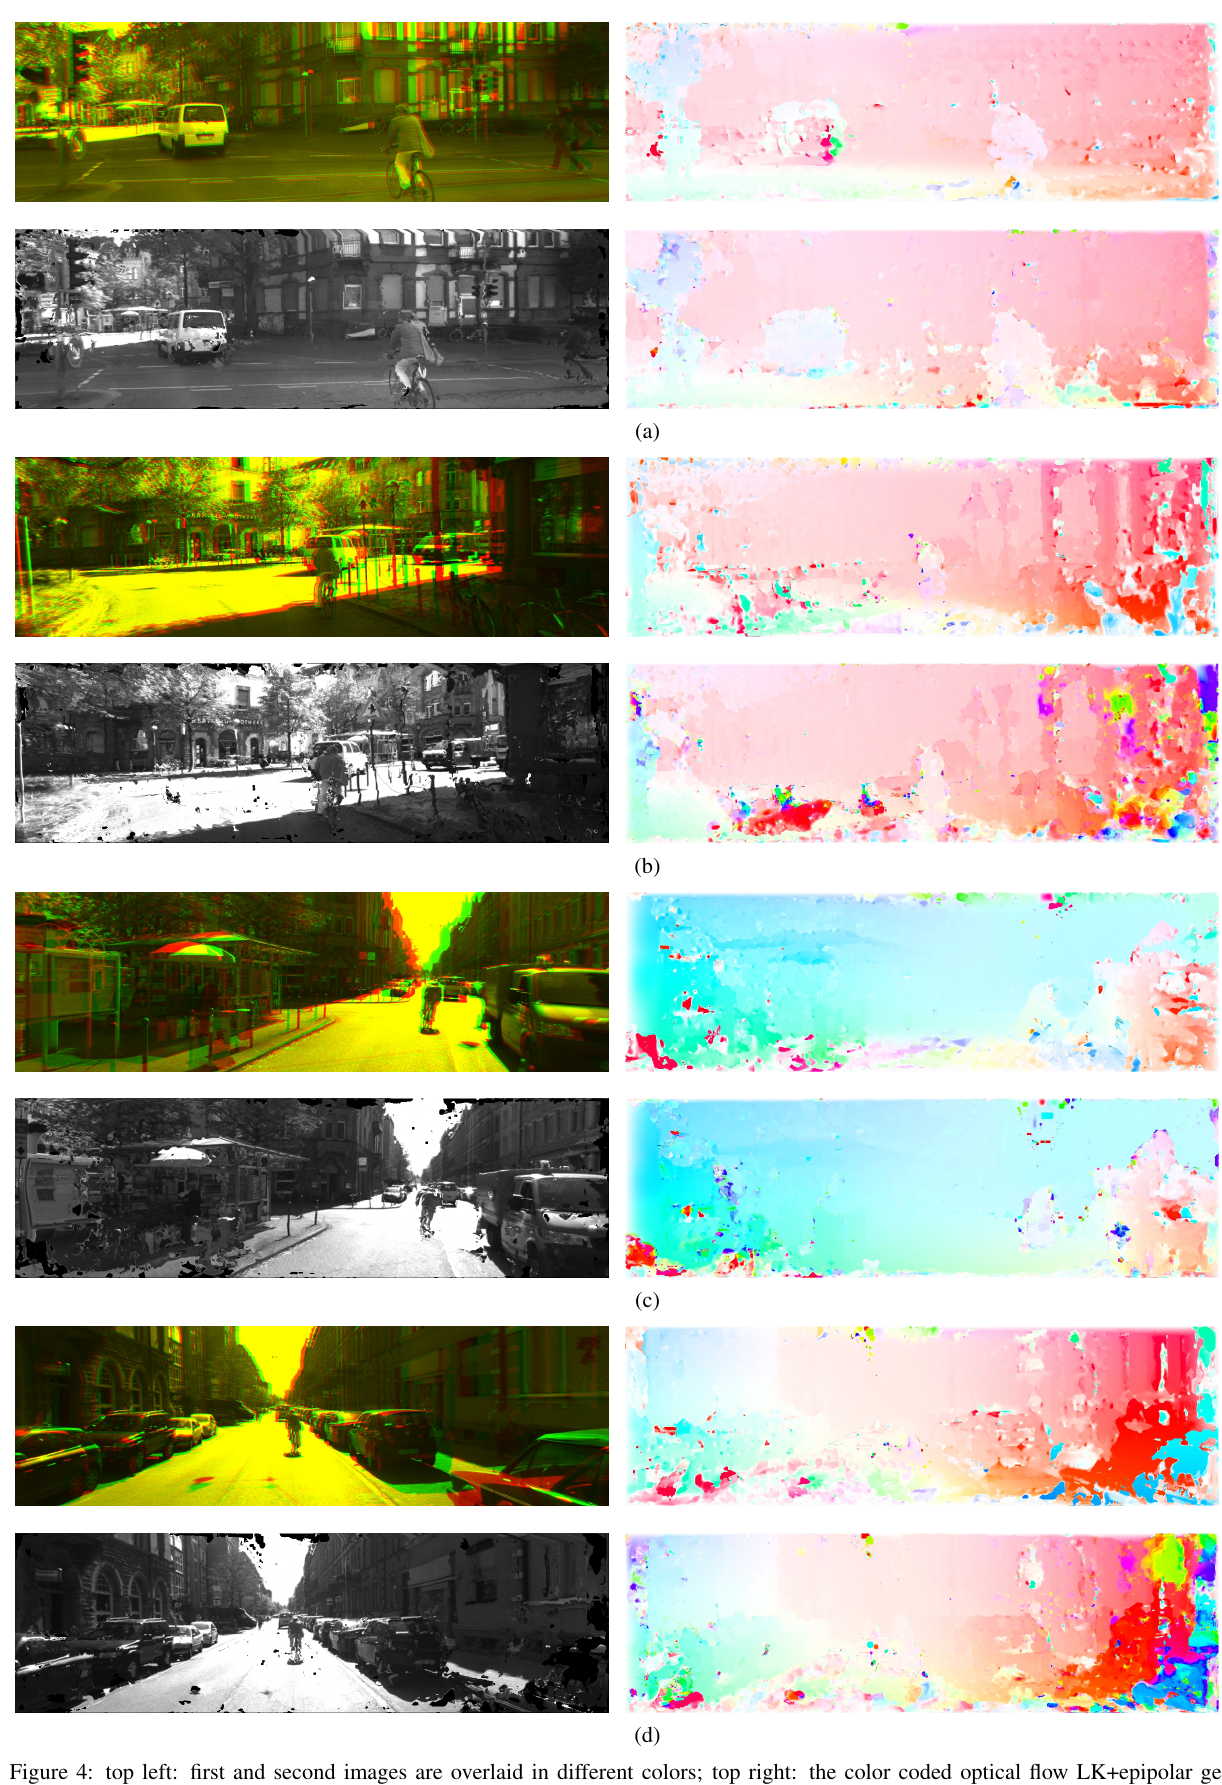
Figure 4: top left: first and second images are overlaid in different colors; top right: the color coded optical flow LK+epipolar geometry constraint; down left: warped image LK+epipolar geometry constraint; down right: warped image LK; a, b, c and d are 1, 50, 100 and 150 frame numbers in the image